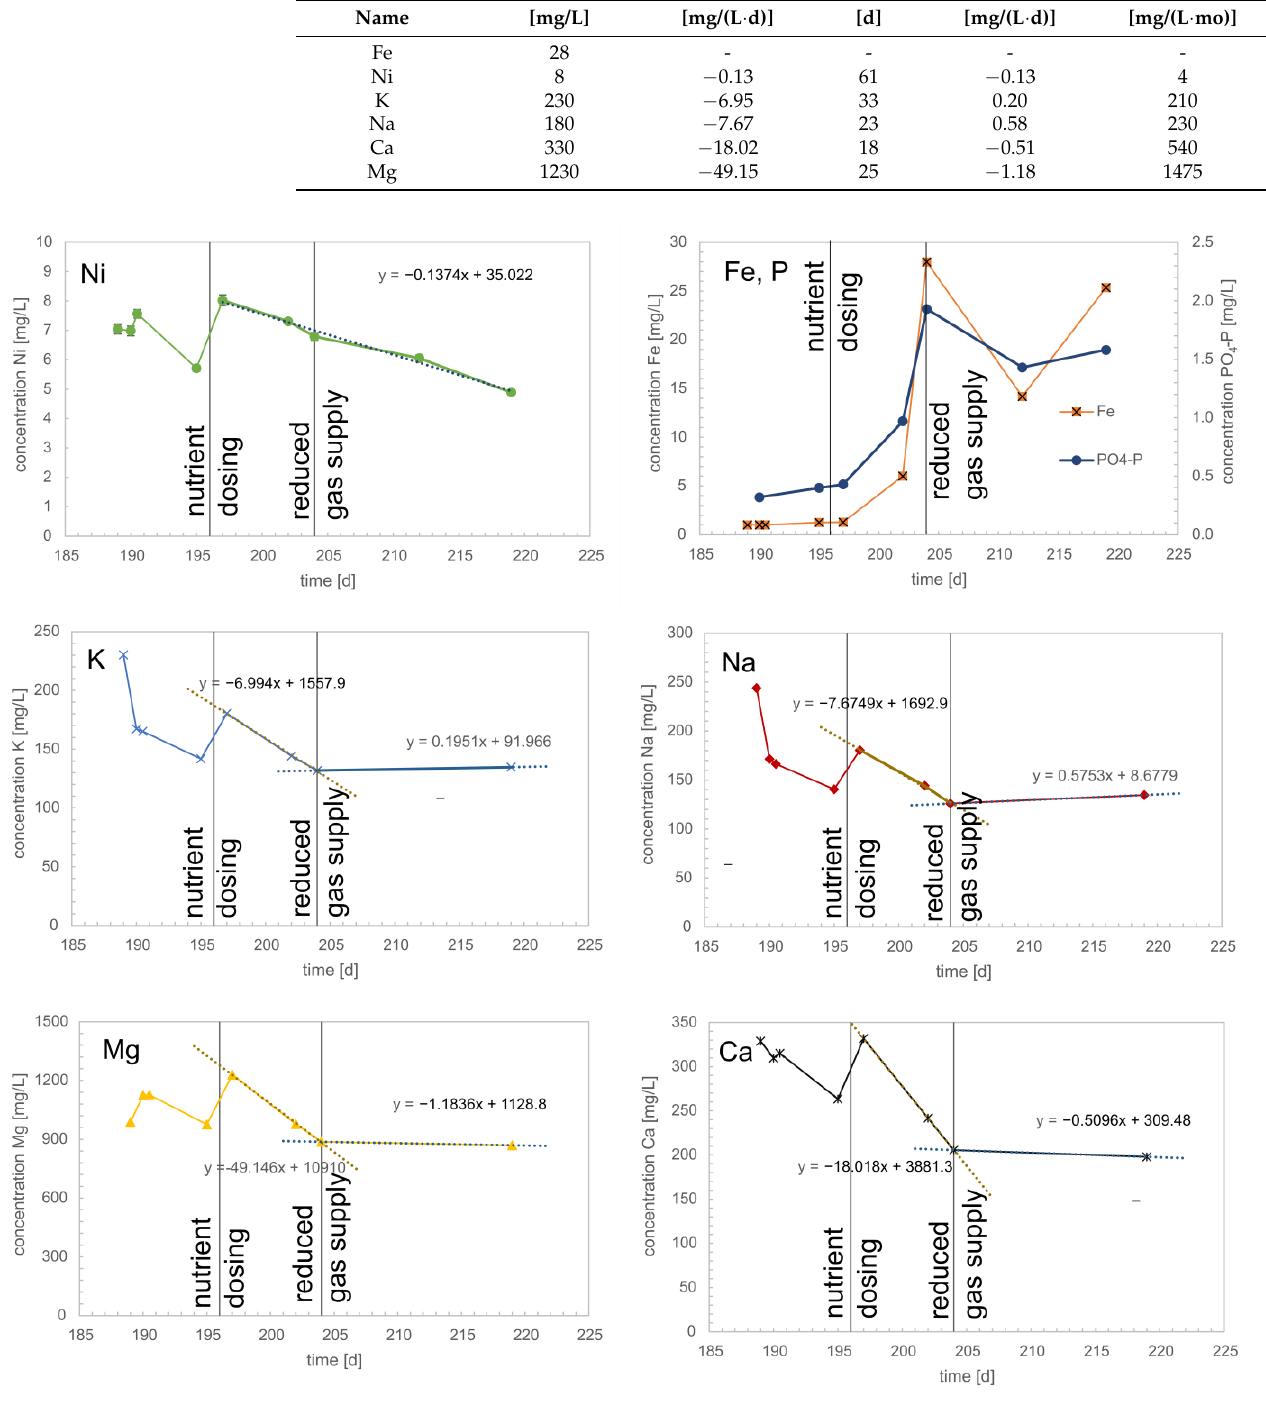
Table 7. Element concentration after dosing, specific daily demand, range after dosing, the amount released by biomass decay, and monthly dosing amount for stable concentrations for Fe, Ni, K, Na, Ca, and Mg.